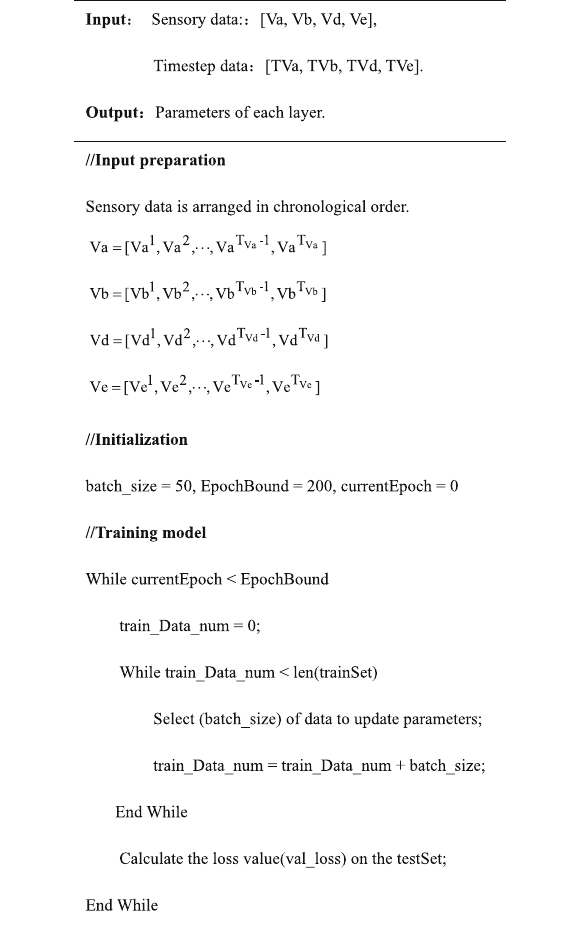
Table 4 Training process of MNMF model